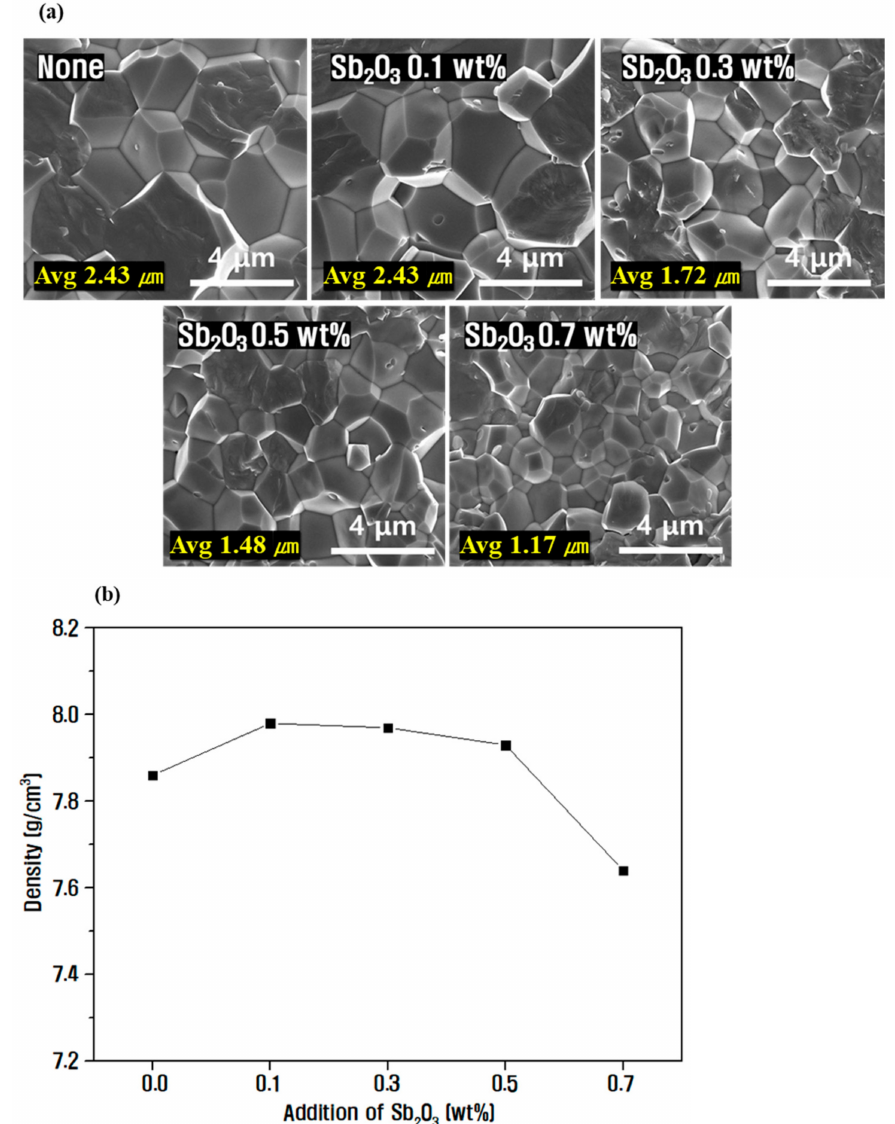
Figure 4. (Inset) FE-SEM images of fracture surfaces with different Sb 2 O 3 doping amounts in 0.08Pb(Ni 1/3 Nb 2/3 )O 3 -0.07Pb(Mn 1/3 Nb 2/3 )O 3 -0.85Pb(Zr 0.5 Ti 0.5 )O 3 ceramic; ( a ) average grain size and ( b ) density measurement